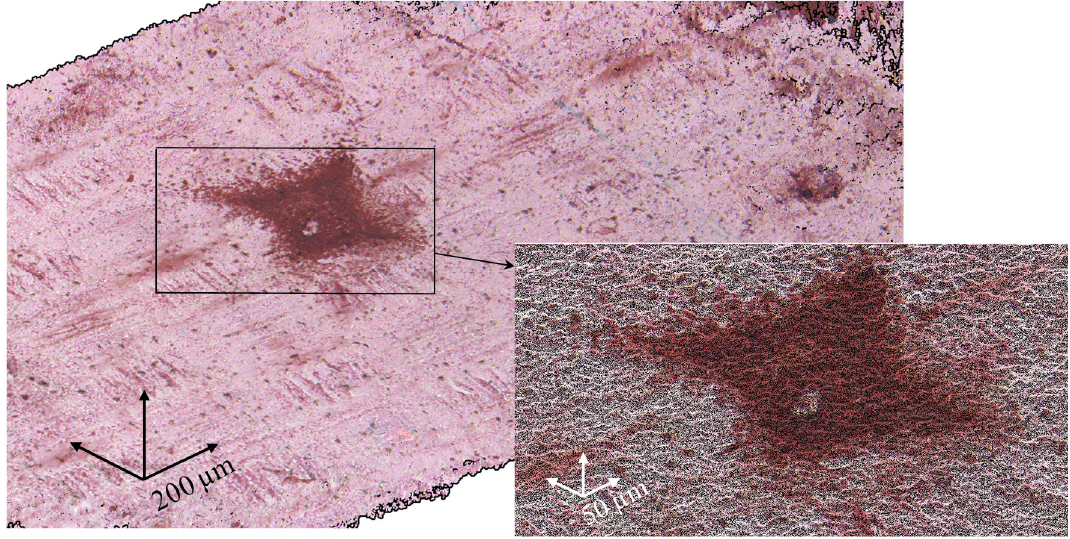
Figure 15. 3D image of the AMX-Sb 2 membrane in the form of photogrammetric point cloud.